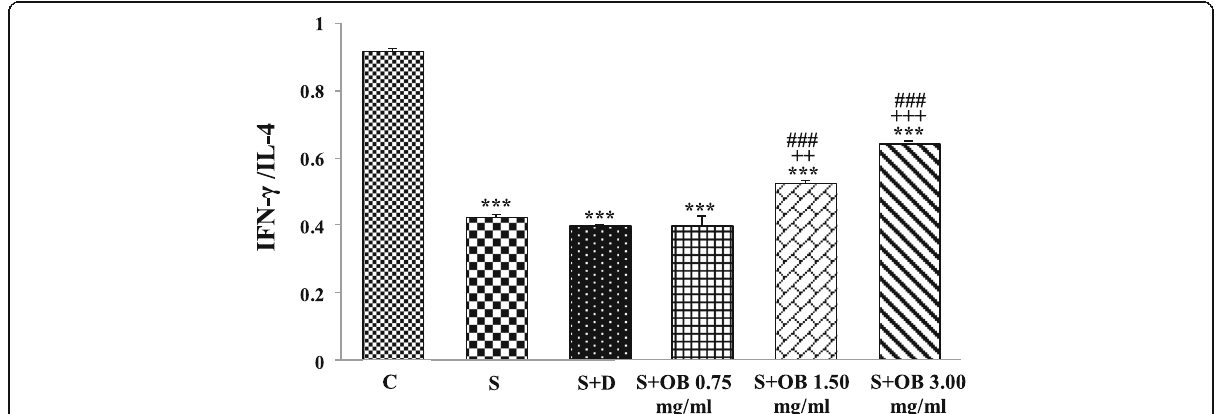
Fig. 3 Values (mean ± SEM) of IFN- γ to IL-4 ratio in the control (C), sensitized (S), treated sensitized animals with dexamethasone (S + D) and three O. basilicum concentrations (S + OB) groups, (in each group, n = 8). ***: P < 0.001, comparison with C group. ++: P < 0.01, +++ P < 0.001, with S group. ###: P < 0.001, comparison with S + D group. One-way analysis of variance (ANOVA) with Tukey-Kramer ’ s post-test was used for